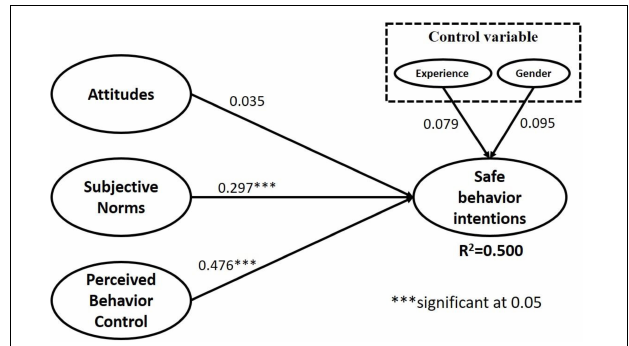
FIGURE 2 | Partial least squares